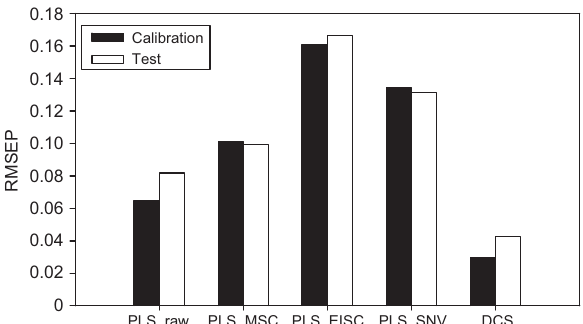
Figure 6 The RMSEP values of different calibration methods for both calibration and independent test samples. (Reprinted with permission from Z.P. Chen et al. Anal. Chem. 2012 , 84 , 4088 – 4094. Copyright 2006 American Chemical